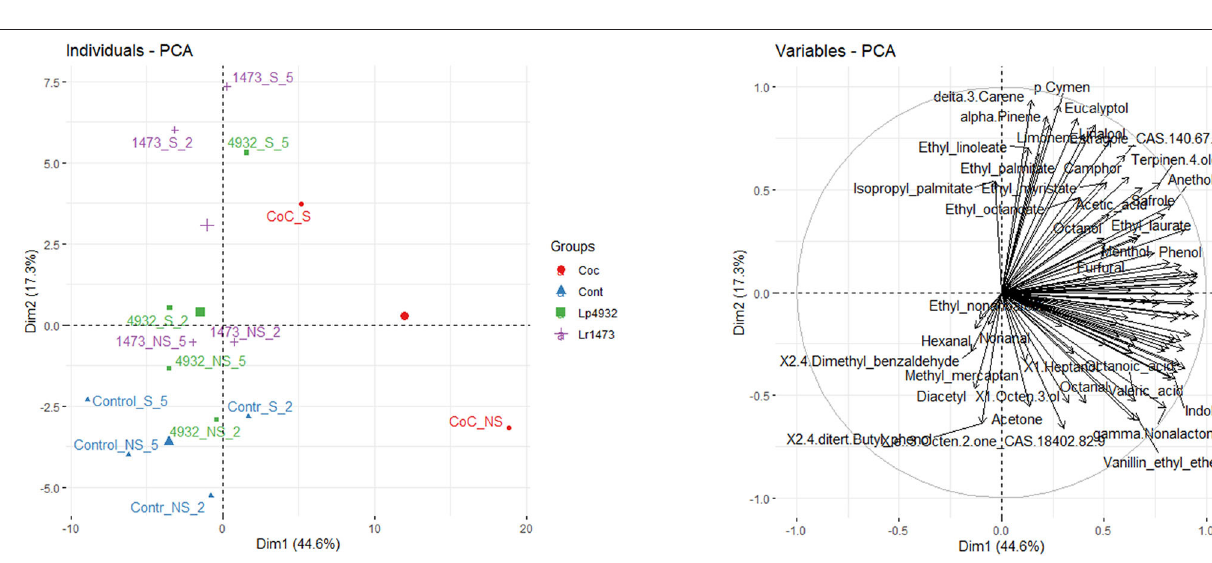
FIGURE 9 | Principal component analysis plot of volatile compounds measured in fermented and unfermented samples of exhausted vanilla beans. Names present in the plot are abbreviated as follows. 1473, Lacticaseibacillus rhamnosus 1473; 4932, Lactiplantibacillus plantarum 4932; CoC, co-culture of L. rhamnosus and L. plantarum ; S, sample with seeds; NS, sample without seeds; 2, sample fermented using condition n.2 of DoE; 5, sample fermented using condition n.5 of DoE; Control, unfermented